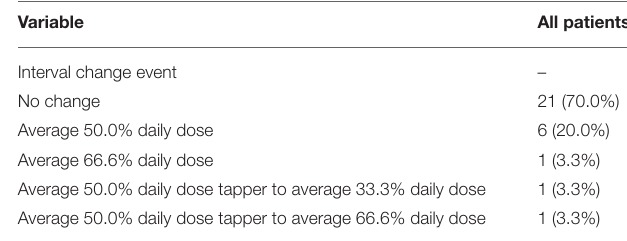
TABLE 4 | Categories of dose interruption (interval